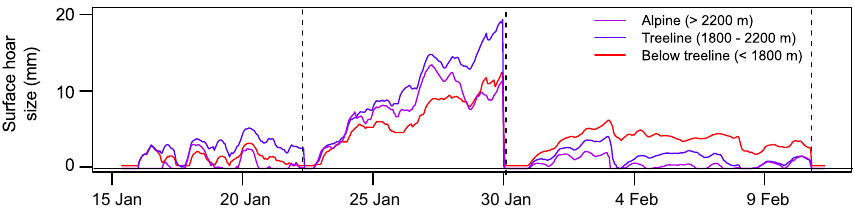
Figure 7. Modelled surface hoar sizes at High-Resolution Deterministic Prediction System (HRDPS) grid points grouped by elevation bands in Glacier National Park. Same format as Fig.